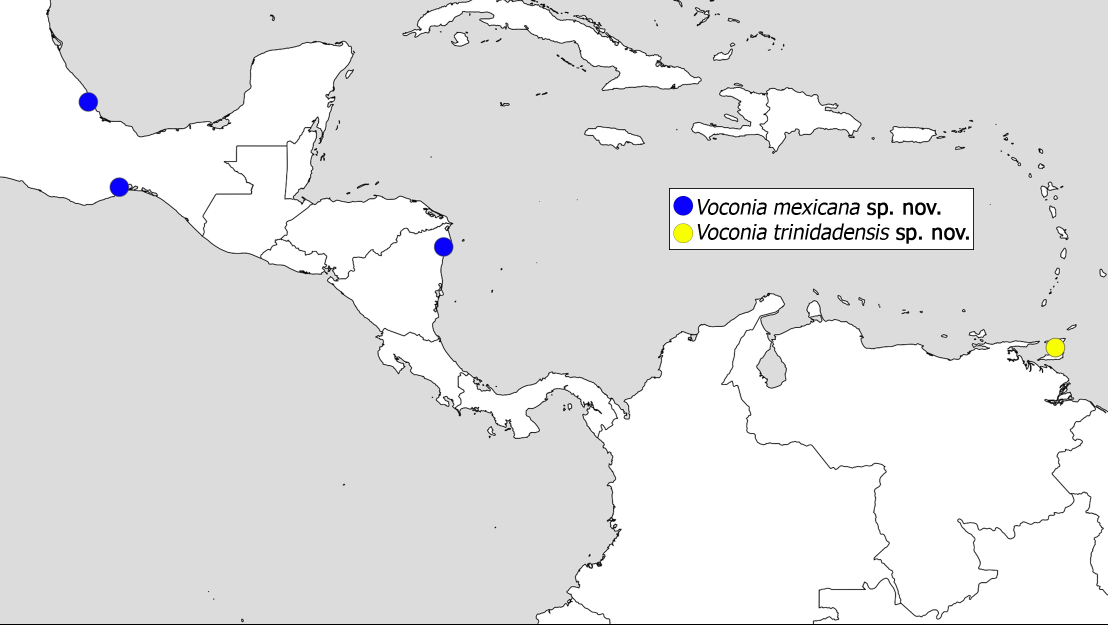
Fig. 19. The distribution of species of Voconia Stål, 1866 in Central